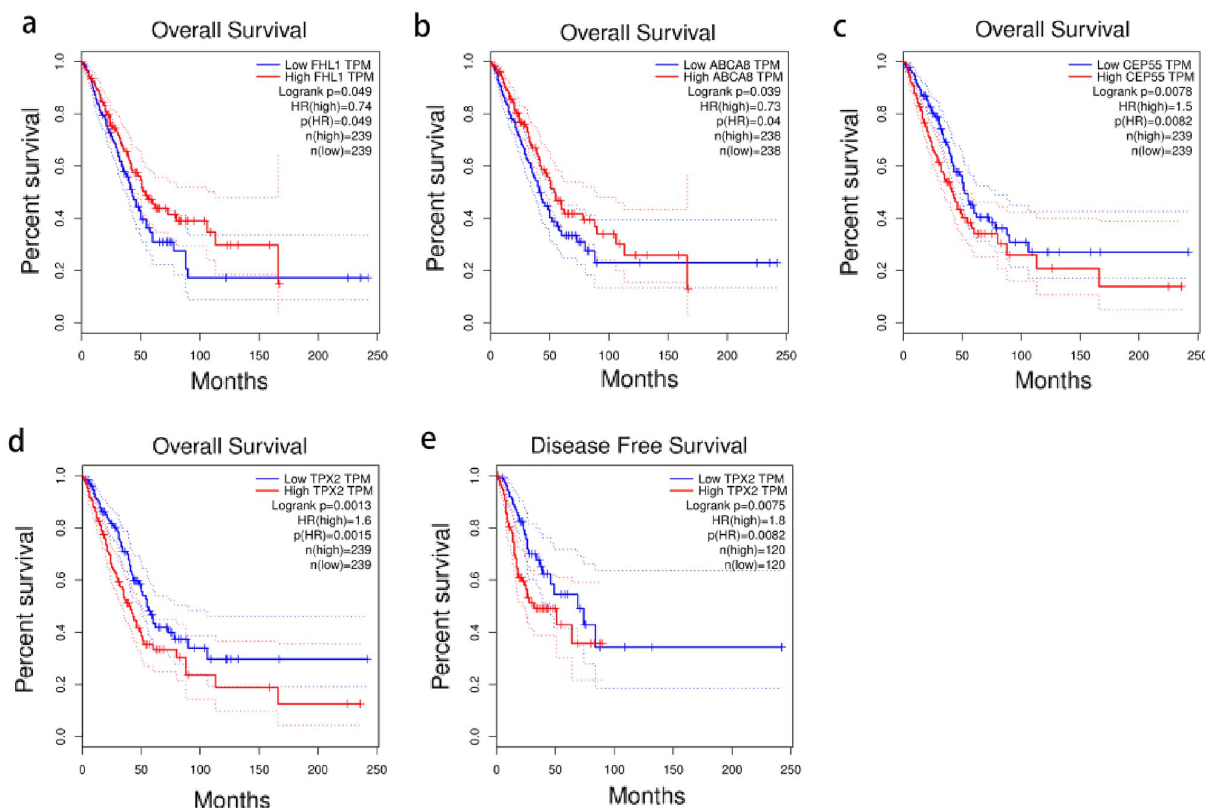
Figure 10. Survival analysis of eight biomarkers in GEPIA website. ( a–d ) Overall survival analysis of FLHI, ABCA8, CEP55, TPX2. ( e ) Disease Free survival analysis of TPX2. P < 0.05 means difference is statistically